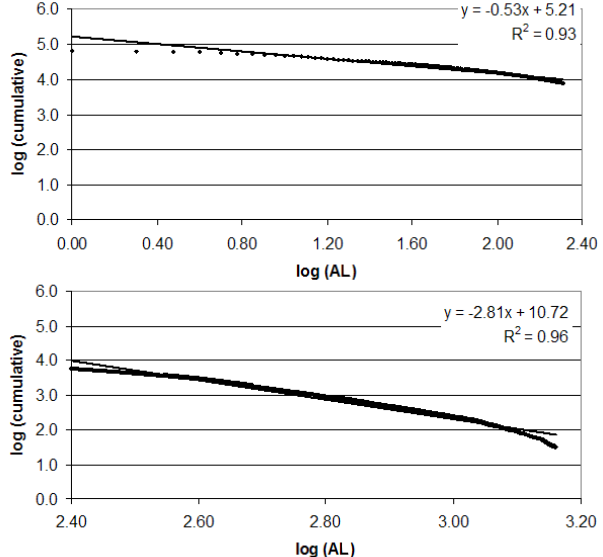
Fig. 6. Magnitude-frequency distribution for the Sym-H index over − 30nT (quiet – top) and less than − 30nT